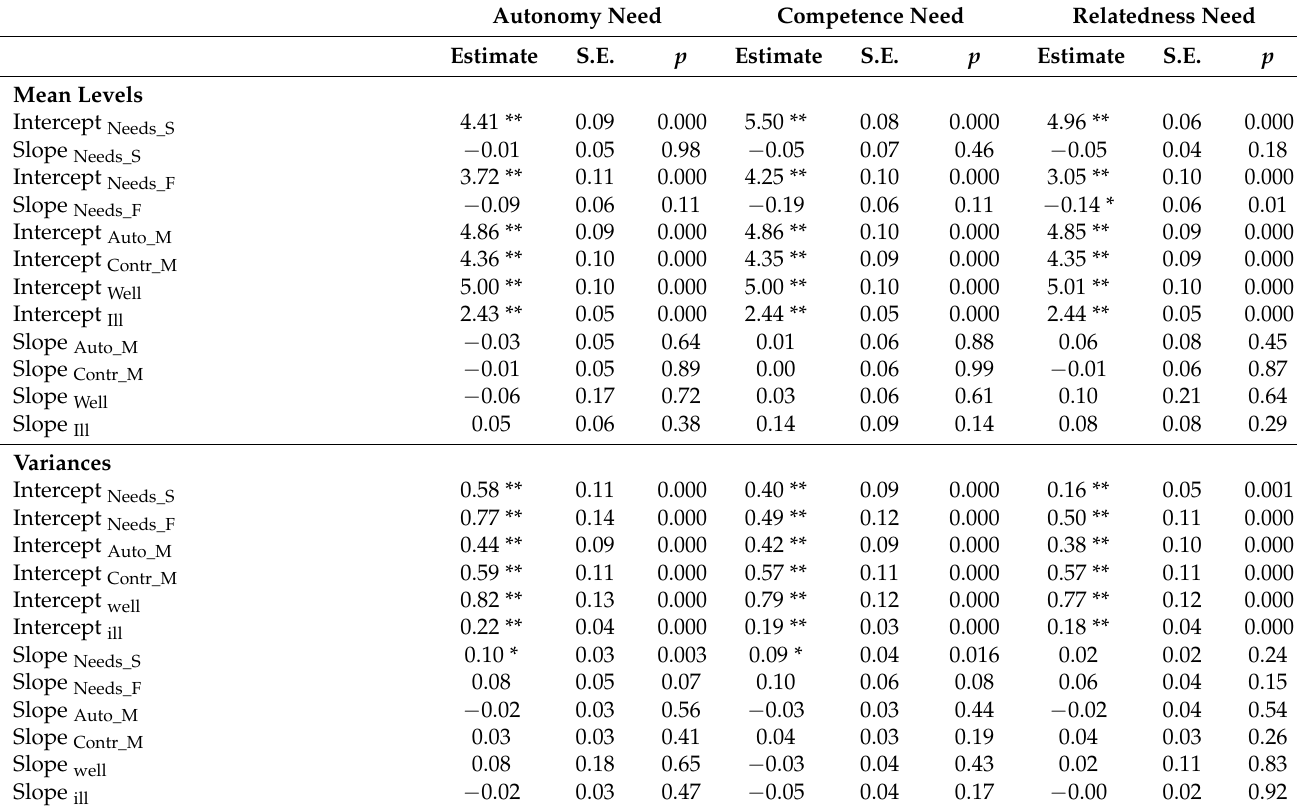
Table 6. Parameter Estimates for LGM Models: Indirect Path